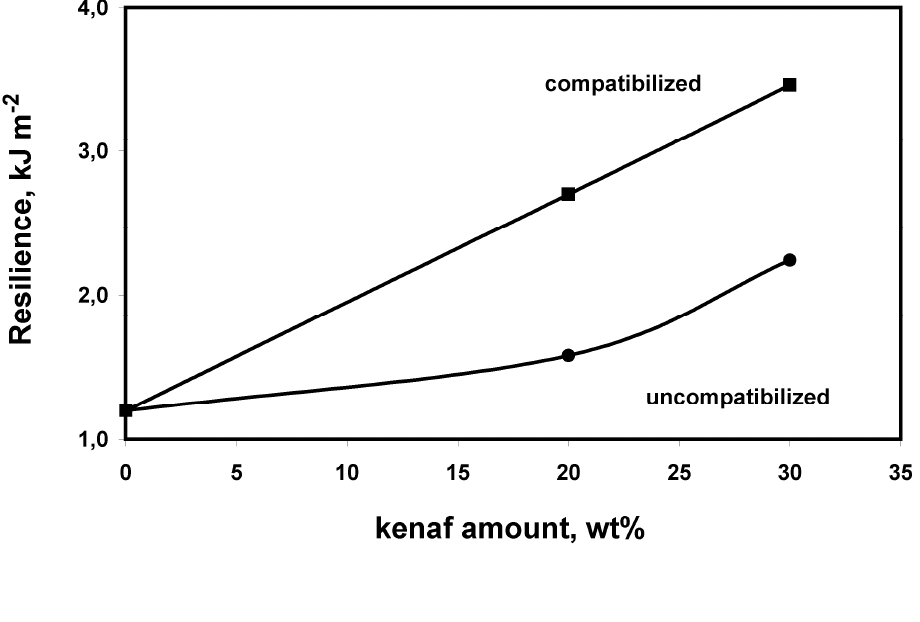
Figure 4. Resilience of PLA based composites as a function of the kenaf content and the